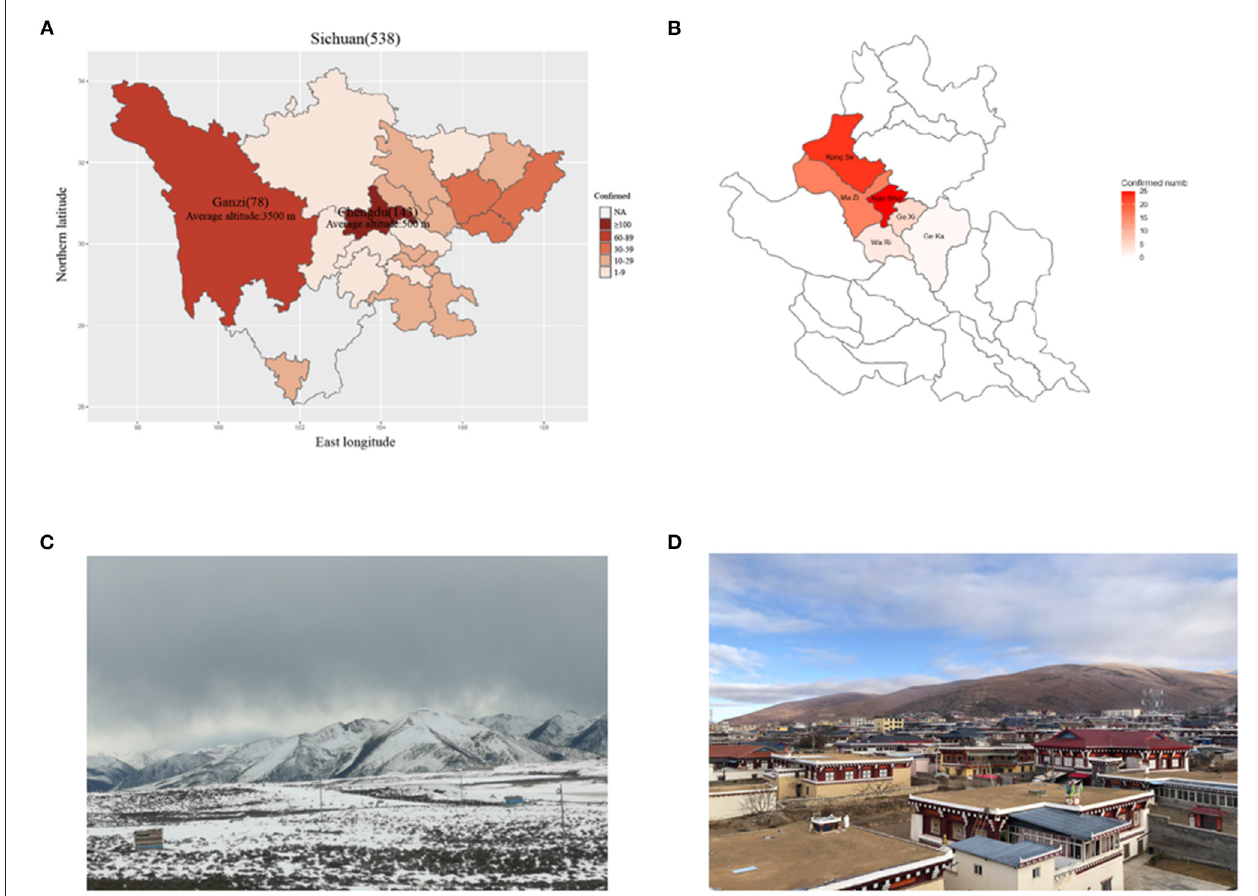
FIGURE 1 | The distribution of COVID-19 cases across Sichuan province. (A) The distribution of patients across Sichuan province. (B) The distribution of patients across Daofu County. (C) The geographical features of Ganzi Tibetan Autonomous Prefecture. (D) High crowd density in Daofu County. The official statistics of all documented laboratory-confirmed COVID-19 cases throughout Sichuan province (March 19,